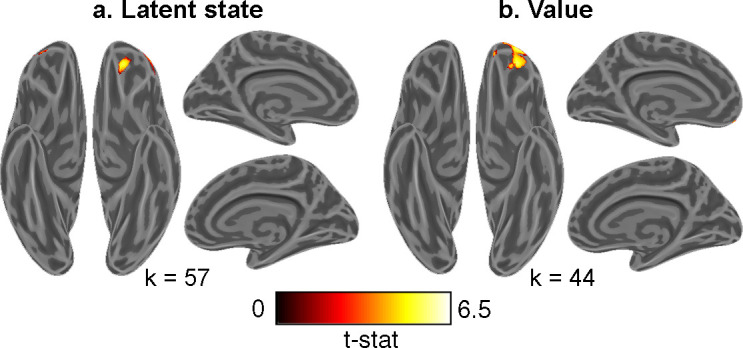
Results of representational similarity analysis searchlight results with explicit mask in orbitofrontal cortex.Maps of t-statistics have been projected onto an inflated cortical surface to show effects for (a) latent states and (b) value. Both maps were defined with a cluster forming threshold of p<0.001 and corrected for multiple comparisons with permutation tests for defining a cluster extent threshold at p<0.05. The cluster extent threshold is given by the value of k.